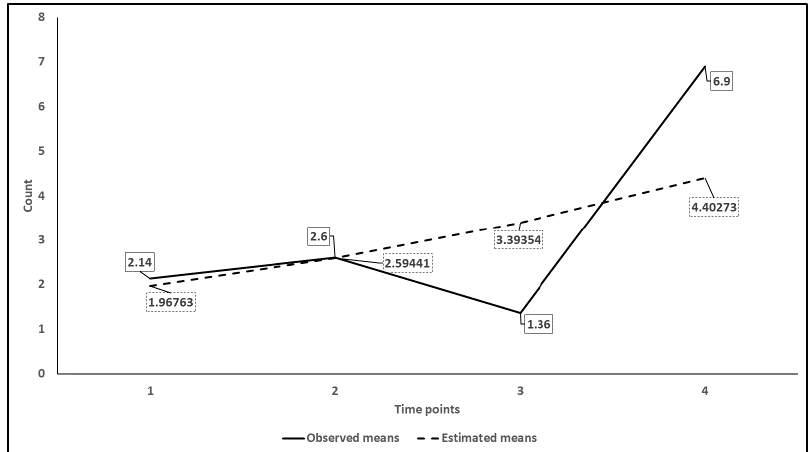
Figure 1. Observed and estimated trajectories from the ZIP LGCM for the N = 50 simulation.